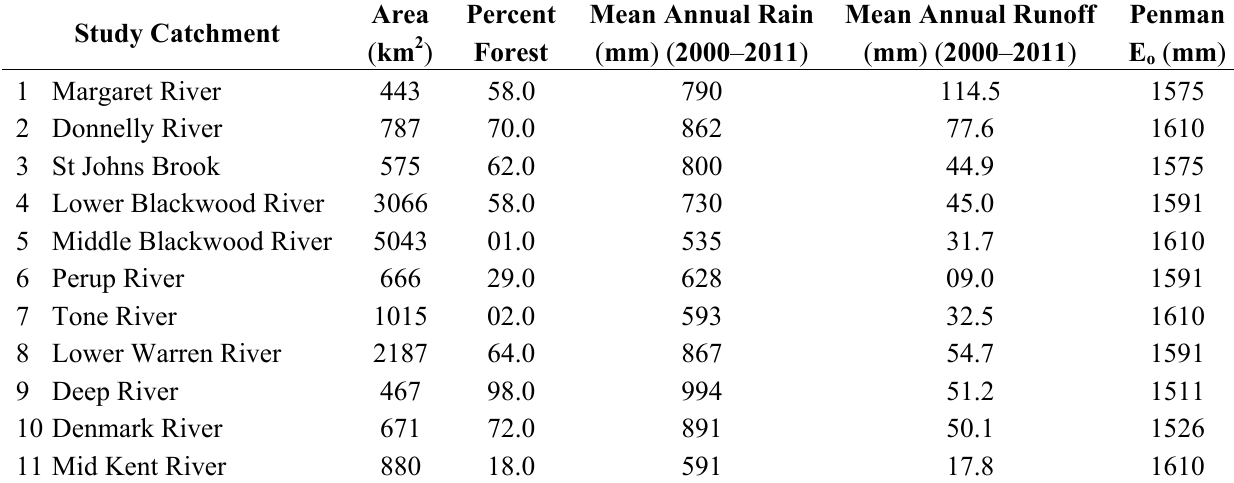
Table 1. Characteristics of the study